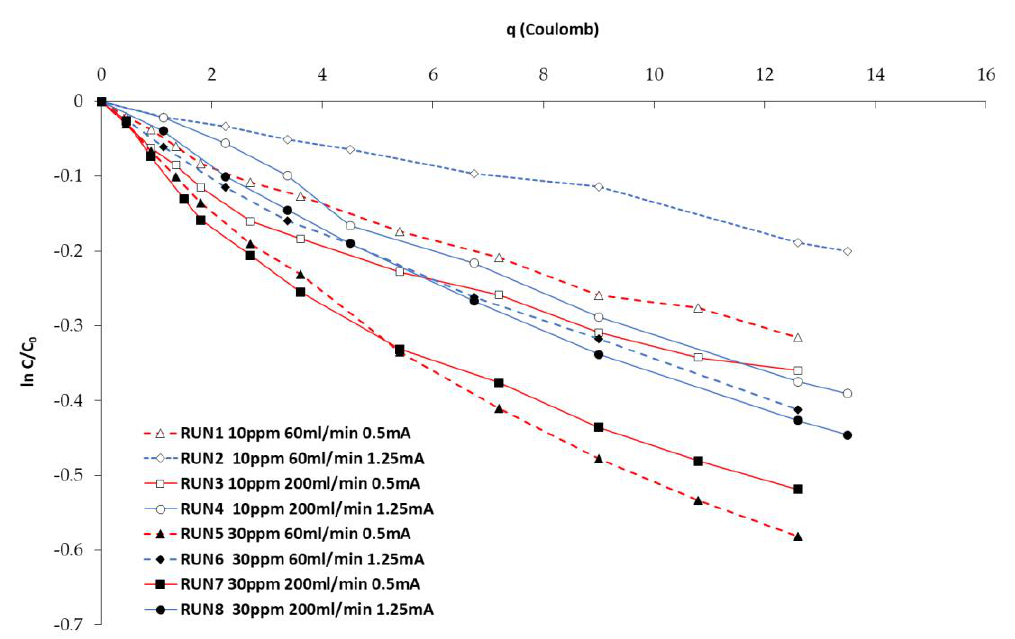
Figure 2. Trend of logarithm of DRN concentration, normalized with respect to its initial concentration, as a function of the electric charge supplied during the galvanostatic electrolyses performed at the irradiated samples, under the different conditions planned in the Design of Experiment (DoE).